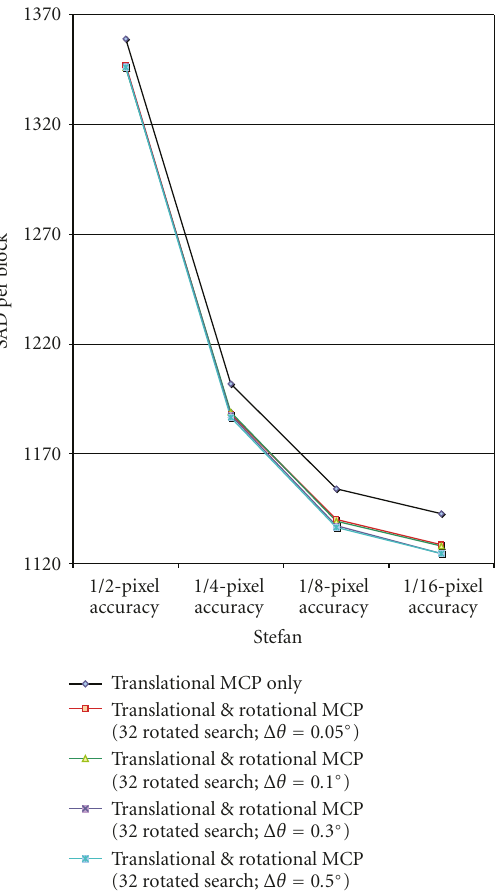
Figure 5: Average SAD per block in sequence Stefan